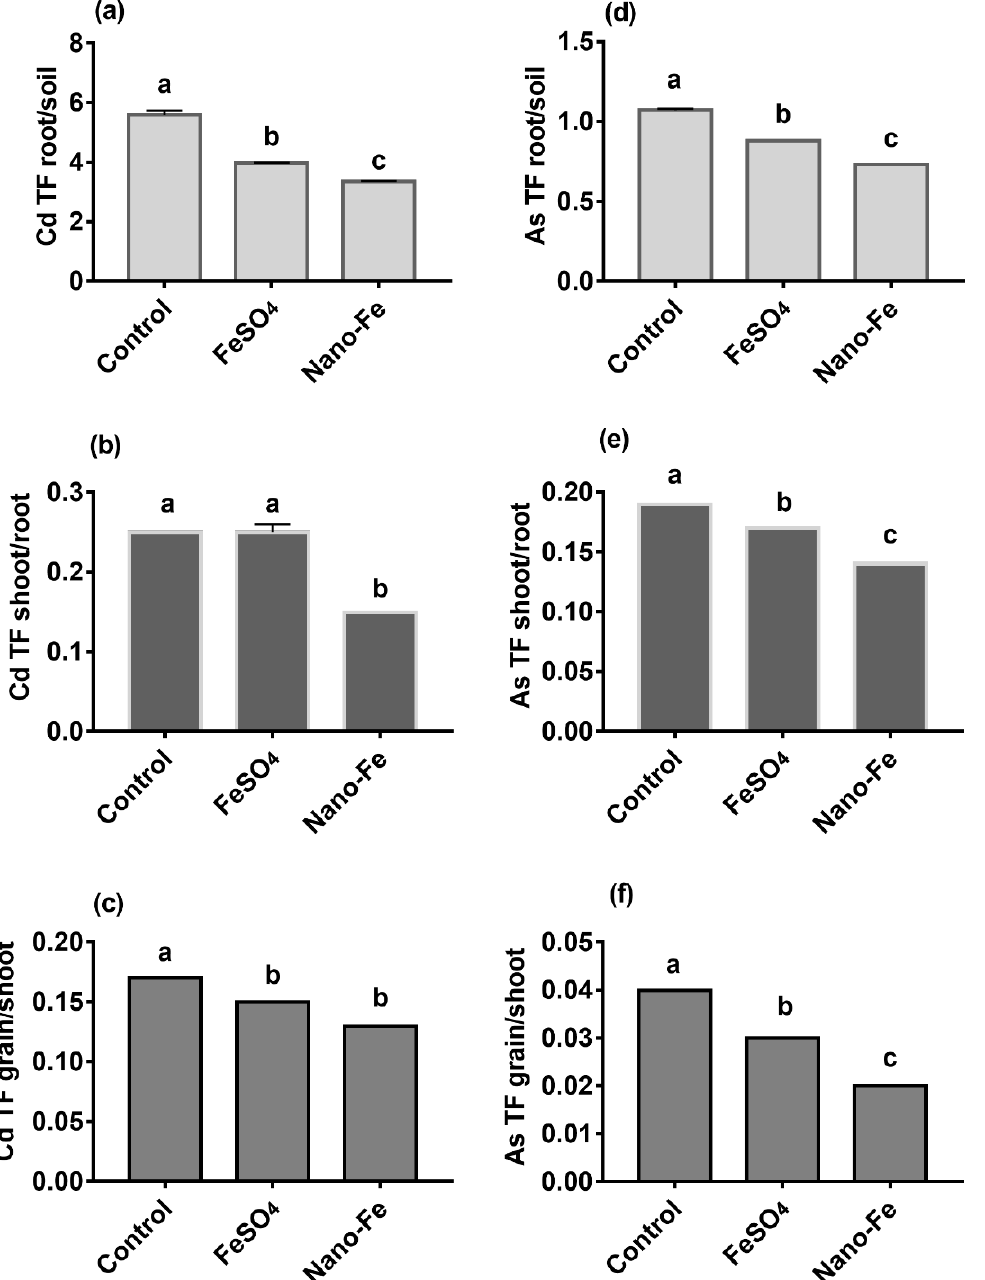
Figure 4. The Cd TF root/soil ( a ), shoot/root ( b ), grain/shoot ( c ), and As TF root/soil ( d ), shoot/root ( e ), grain/shoot ( f ) of rice derived from treatments with exogenous Fe applied as FeSO 4 or Nano-Fe. Different lowercase letters in the columns indicate a significant difference among the different treatments at p < 0.05 .